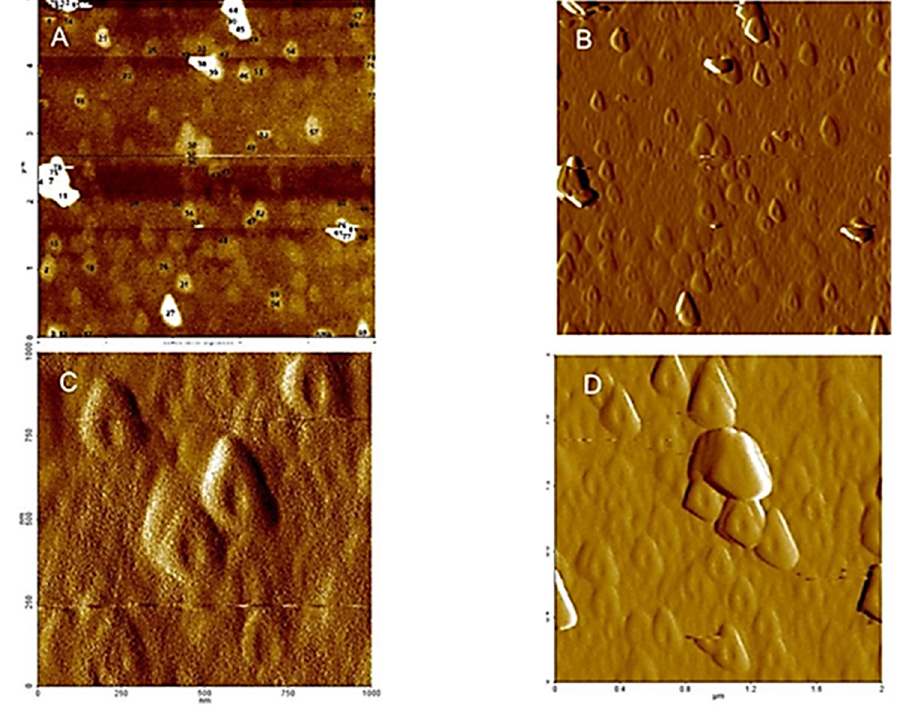
Figure 3. AFM − NC (non-contact tapping mode): ( A , C ) microtopography amplitude and ( B , D ) 3D microtopography images of HA dispersed in pure water at pH 5, adsorbed and then dried on a mica surface.